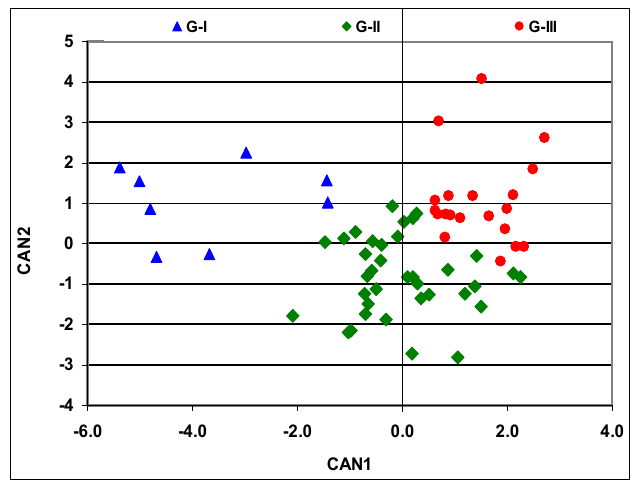
Figure 1. Scatter plot of the two canonical discriminant functions (CAN1 and CAN2) for carotenoids of maize hybrids, with those marked blue belonging to the first group (G-I), hybrids marked green included in the second group (G-II), and hybrids marked red representing the third group (G-III), that were measured in regional trials evaluated across 23 test environments from 2015 to 2018. Table 3. Minimum, maximum, and mean carotenoid concentrations for three groups of hybrids (G-I, G-II, and G-III) de- fined based on canonical discriminant analyses. Carotenoids